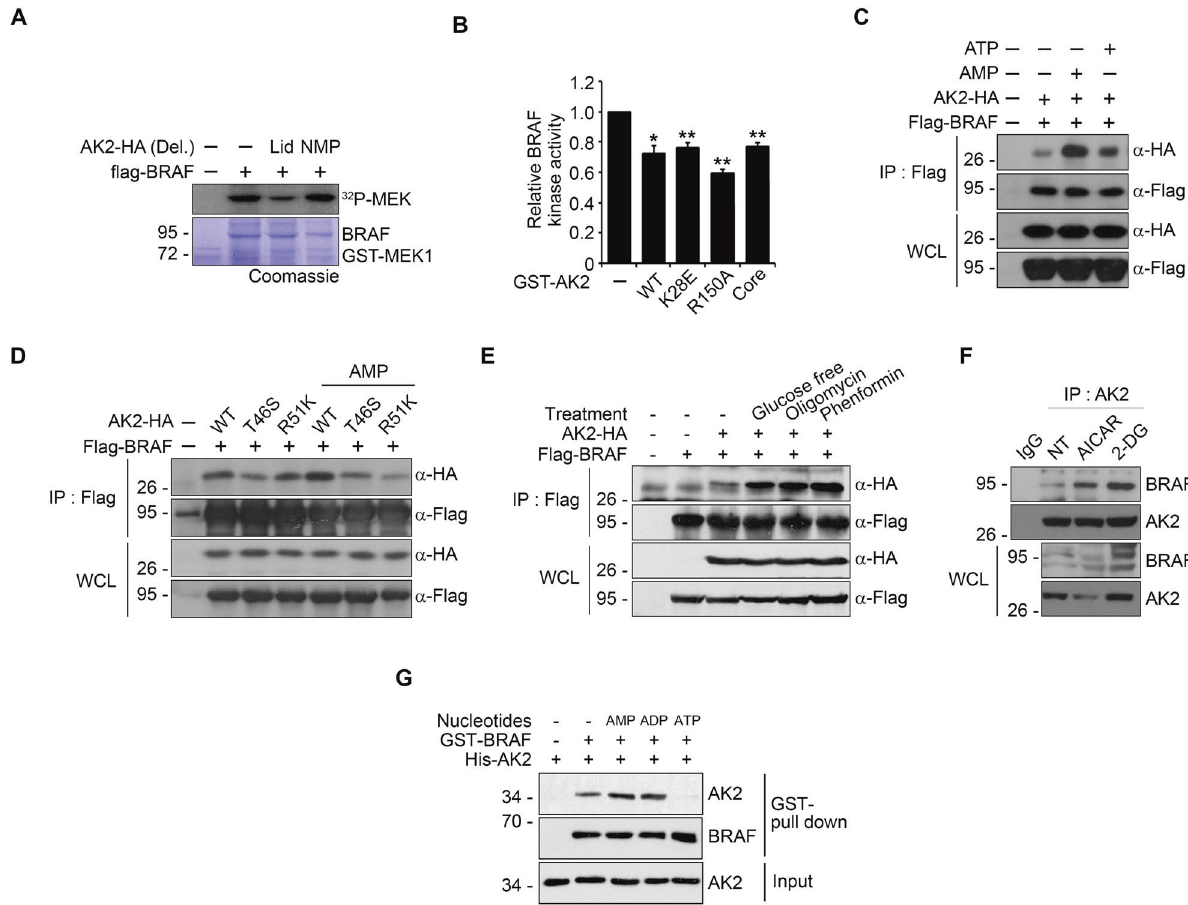
Fig. 2 AMP potentiates the ability of AK2 to inhibit BRAF activity via enhanced af fi nity between AK2 and BRAF. A AK2 NMP domain is crucial to modulate BRAF kinase activity. HEK293T cells were transfected with Flag-BRAF and HA-AK2 deletion mutants for 24 h and subjected to kinase assay after immunoprecipitation (IP) assay using anti-FLAG agarose-beads. B AK2 activity-dead mutants suppresses BRAF activity in vitro. BRAF protein (10 nM) was incubated with GST-AK2 WT (1 μ M) or mutant proteins (GST-AK2 K28E, R150A, and Core, 1 μ M). Values are presented as mean ± SD ( n = 3; * p < 0.05, ** p < 0.01, *** p < 0.001). C AMP enhances the AK2 – BRAF binding. After transfection of HEK293T cells with Flag-BRAF and AK2-HA, cell extracts were incubated for 12 h with 100 μ M AMP or ATP and subjected to immunoprecipitation (IP) assay. D AMP binding-defective AK2 mutants lose AMP-stimulation of AK2-binding to BRAF. After transfection of HEK293T cells with BRAF and either AK2 WT or mutants (T46S or R51K), cell lysates were incubated with 100 μ M AMP and subjected to immunoprecipitation assay. E Energy deprivation conditions enhance AK2-HA – Flag-BRAF binding. After transfection of HEK293T cells with Flag-BRAF and AK2-HA, cells were incubated under the following condition; glucose-free DMEM (4 h), oligomycin (1 μ g/ml, 2 h), or phenformin (40 μ M, 2 h). Cell lysates were subjected to immunoprecipitation (IP) assay. F Energy deprivation promotes the interaction between endogenous AK2 and BRAF. SK-Hep1 cells were treated with 2-DG (25 mM) or AICAR (1 mM) for 12 h and then subjected to immunoprecipitation (IP) assay. G AMP or ADP potentiates the AK2 – BRAF binding in vitro. Puri fi ed GST-BRAF and His-AK2 proteins (each 1 μ g ml − 1 ) were combined together for 1 h in the presence or absence of AMP, ADP, or ATP and then subjected to GST pull-down assay. The pulled-samples and inputs were analyzed by western